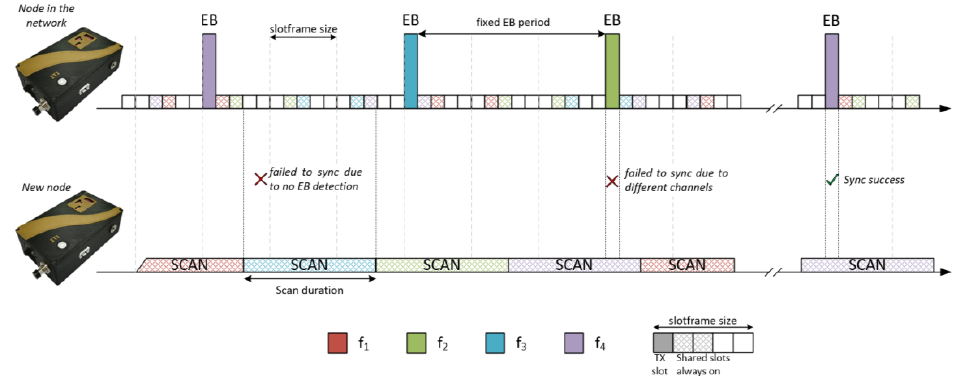
Figure 3 . The TSCH method’s scan and synchronization phase. EB, enhanced beacon. Figure 3. The TSCH method’s scan and synchronization phase. EB, enhanced